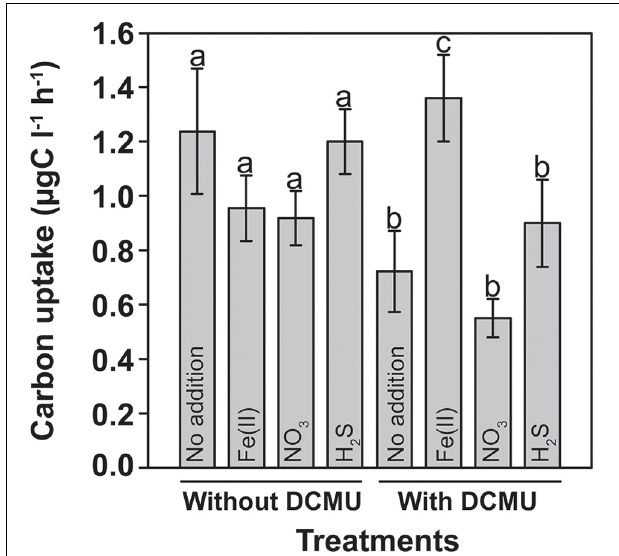
FIGURE 4 | In situ light dependent inorganic carbon uptake in presence of potential substrates for iron- and sulfur-transforming microorganisms. Results show highest stimulation of bicarbonate uptake upon Fe(II) addition at 15m and 15.5m, the depths where anoxygenic phototrophs were most abundant. Net photosynthetic carbon uptake was obtained by subtracting the dark incubation values from the carbon uptake in the light. N-serve and DCMU were added to inhibit nitrification and PS(II) of oxygenic phototrophs, respectively. Means of duplicate experiments are given, with bar ends indicating highest and lowest values. Winter stratification conditions